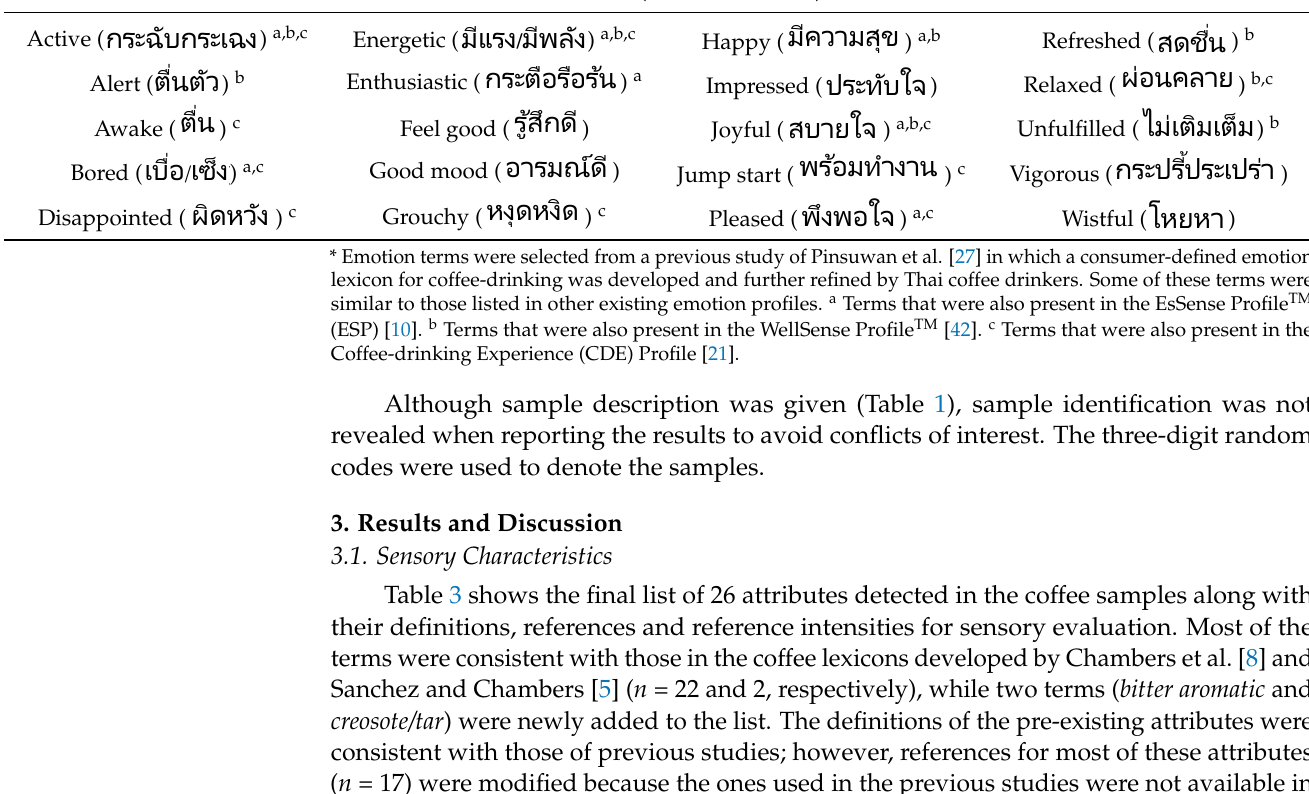
Table 2. A list of 20 emotion terms with Thai translation evaluated in the study.